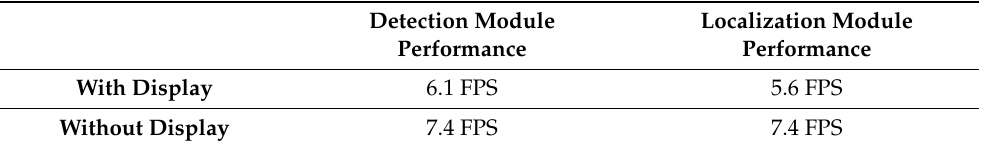
Table 6. Frame rate of Detection and Localization modules running the system with or without data